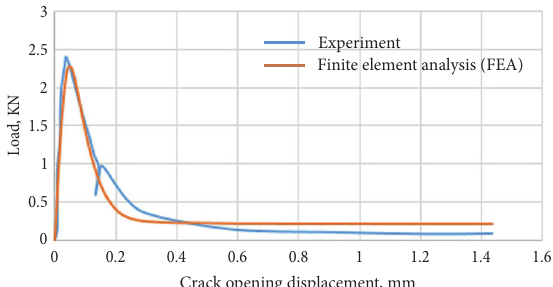
Table 5. Summary of the numerical and test results Experiment [17] Numerical simulation